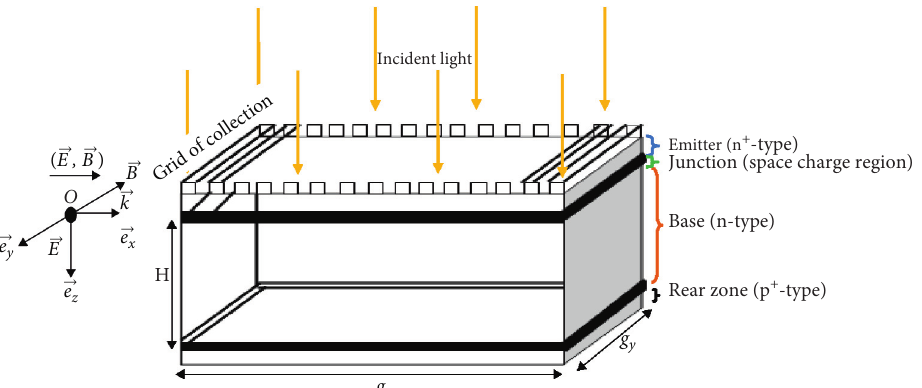
Figure 1: Illuminated polysilicon grain under the electromagnetic